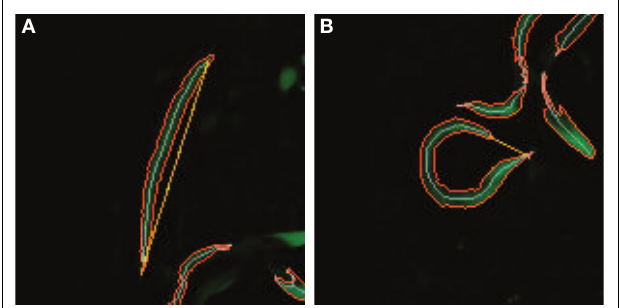
FIGURE 3 | Distance-length ratio in a straight/dead (A) and curved/alive (B) C . elegans .The values for the DLR are (A) 116/112 = 1.04 and (B) 21/104 = 0.20.The skeleton length is represented by the number of pixels in the skeleton, and therefore, the ratio may exceed 1.The cyan line represents the skeleton length, and the yellow line the end-to-end length.